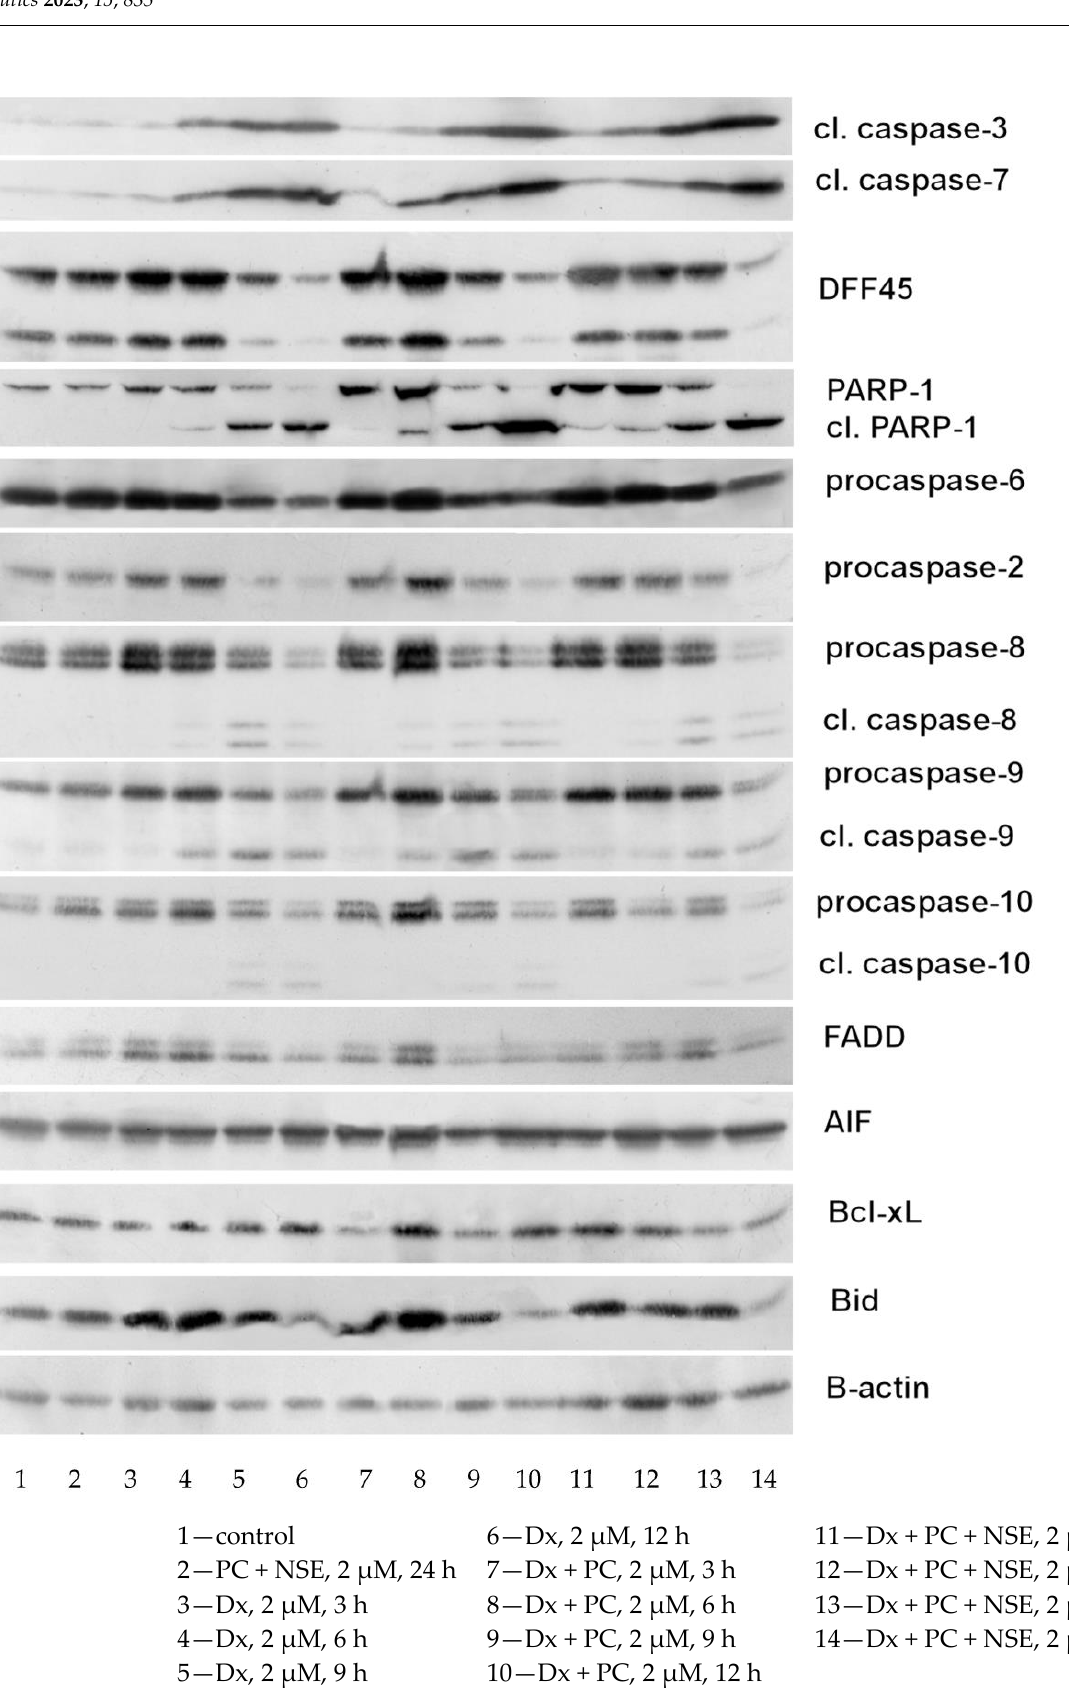
Figure 9. Time-dependent changes in cell death signaling pathways in human Jurkat T-leukemia cells under treatment of various concentrations of Dx, Dx-PC and Dx-PC-NSE.